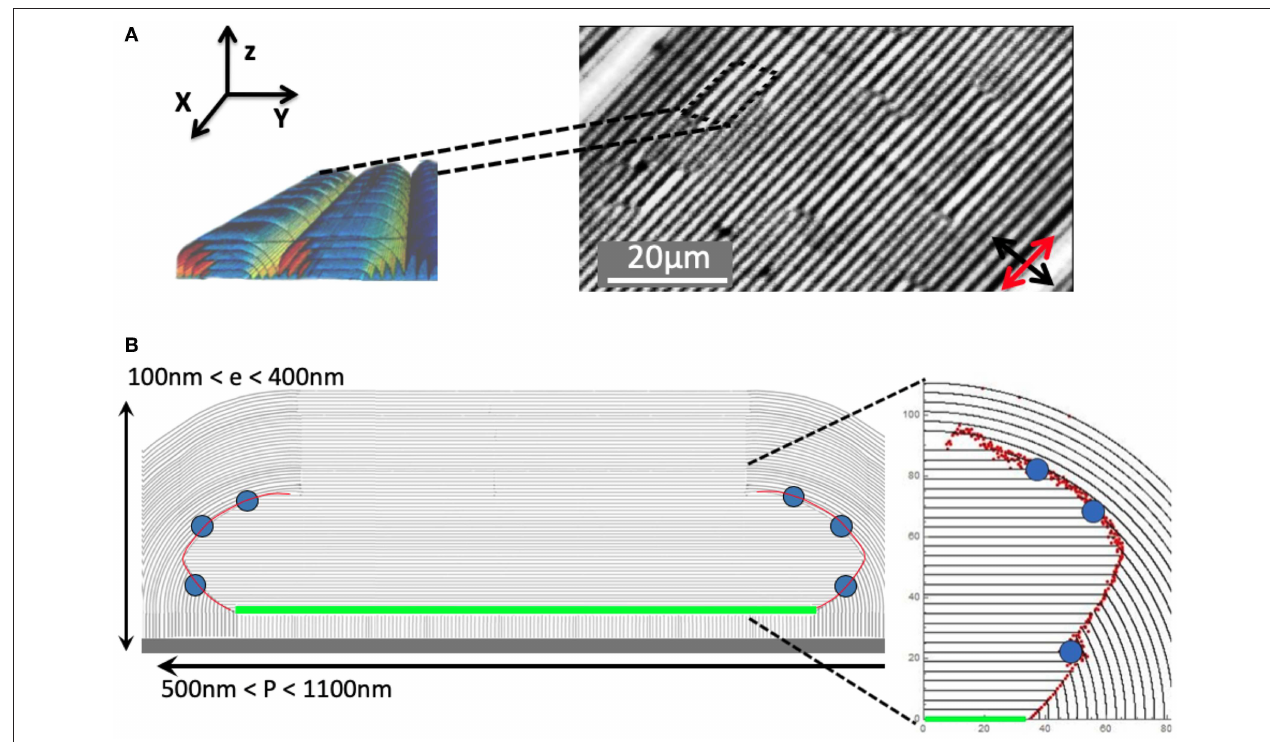
FIGURE 1 | (A) Polarized optical microscopy image of oily streaks observed from the top of a 150 nm-thick sample. Each stripe along OX corresponds to one hemicylinder and two hemicylinders in perspective are represented (B) Detail in side-view [in the (Y, Z) plane] of the smectic layers stacked in one given flattened hemicylinder for a typical thickness of 230 nm. Two rotating grain boundaries are shown in red, including dispersed edge dislocations (blue spots). A central grain boundary is underlined in green [27].